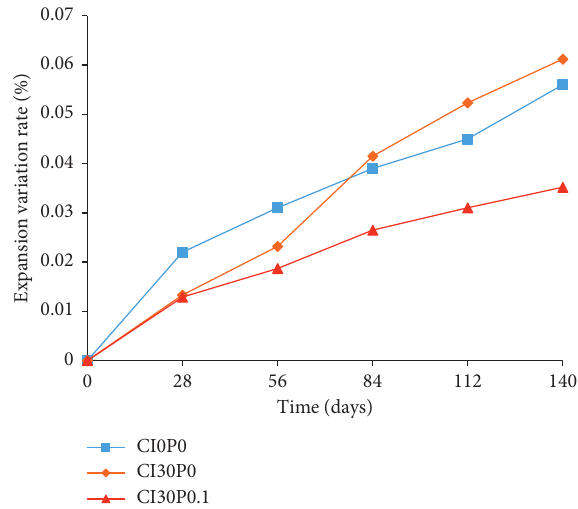
Figure 11: Expansion variation rate of the concrete under 140 days of drying-wetting cycles in 5% Na